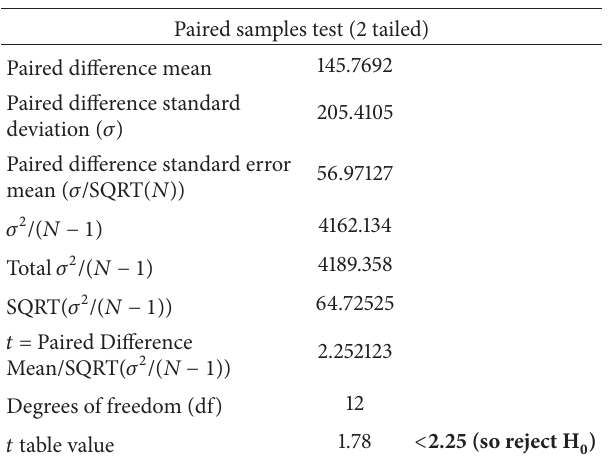
Table 7: Paired samples test.